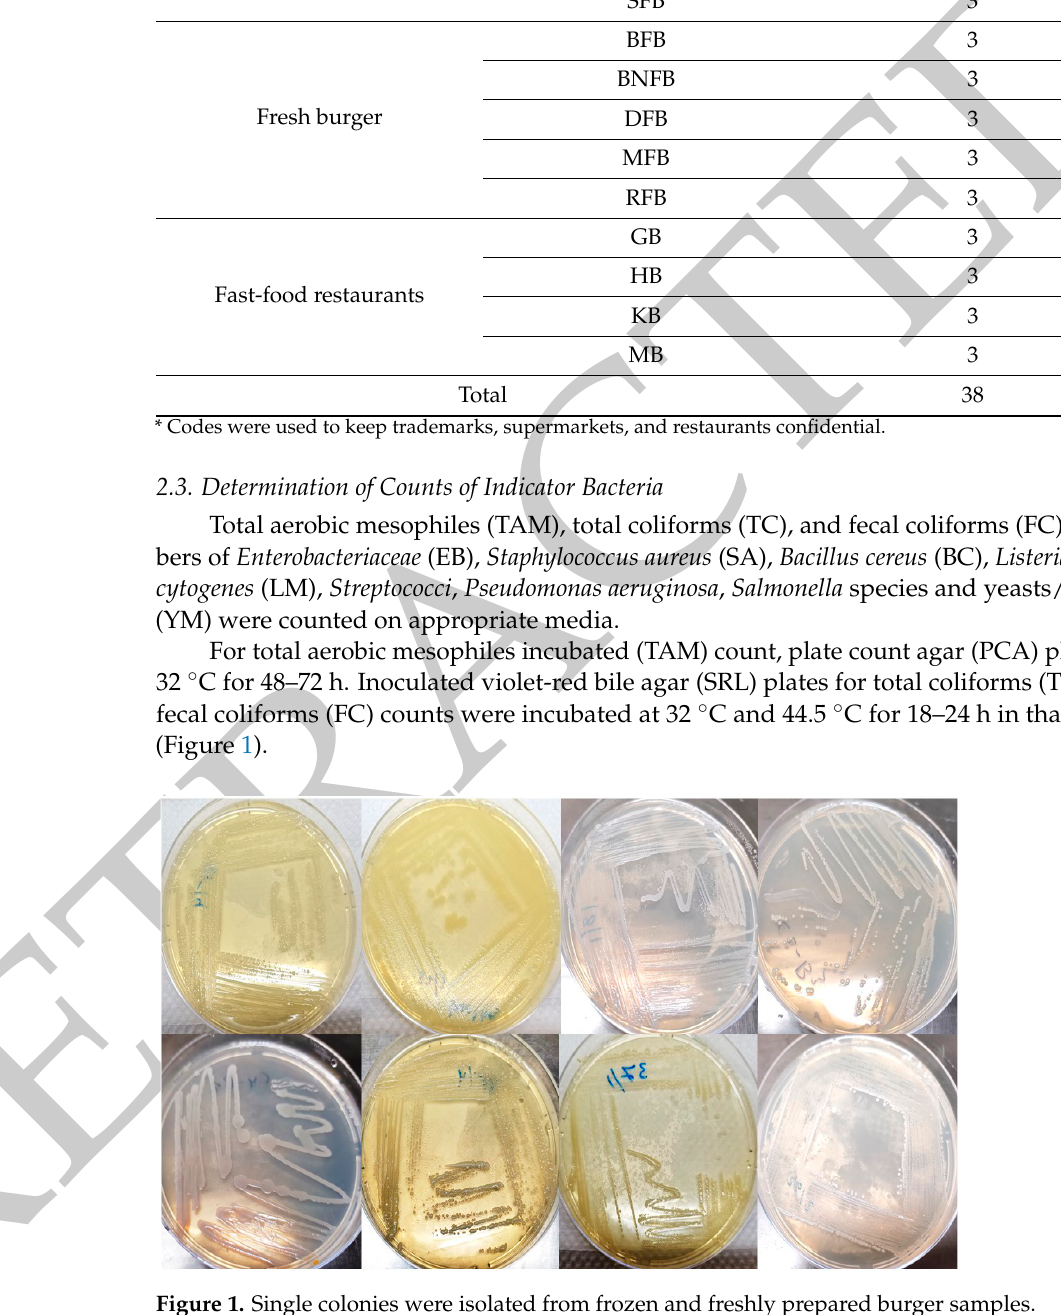
Figure 1. Single colonies were isolated from frozen and freshly prepared burger